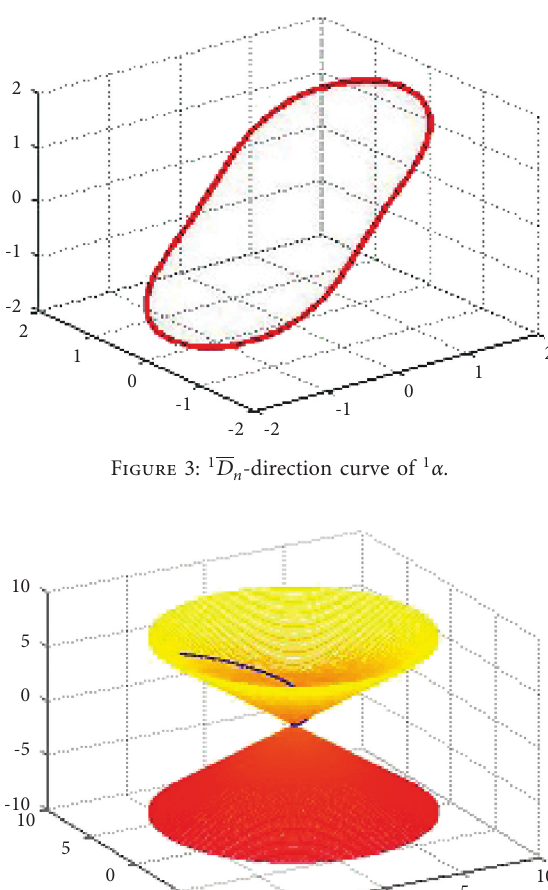
o -direction curve of